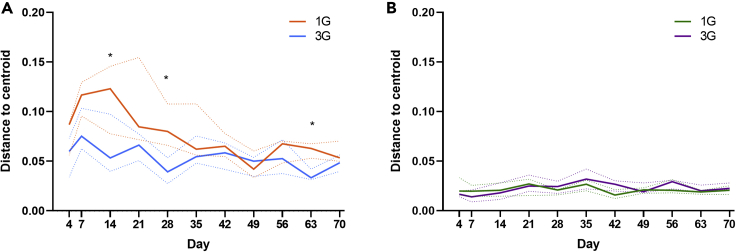
Distance to group centroid of the recipient microbiotaCompositional variance of microbiota among recipient mice that received (A) native microbiota or (B) microbiota derived from antibiotic-disrupted mice were determined based on distances to their respective group centroid at each time point throughout the 70-day study period. Recipient mice received either one round (1G) or three rounds (3G) of donor microbiota. The solid and dotted lines denote the median and interquartile ranges, respectively. Statistical comparison between the 1G and 3G groups at each time point was performed using the Mann-Whitney test (p < 0.05).